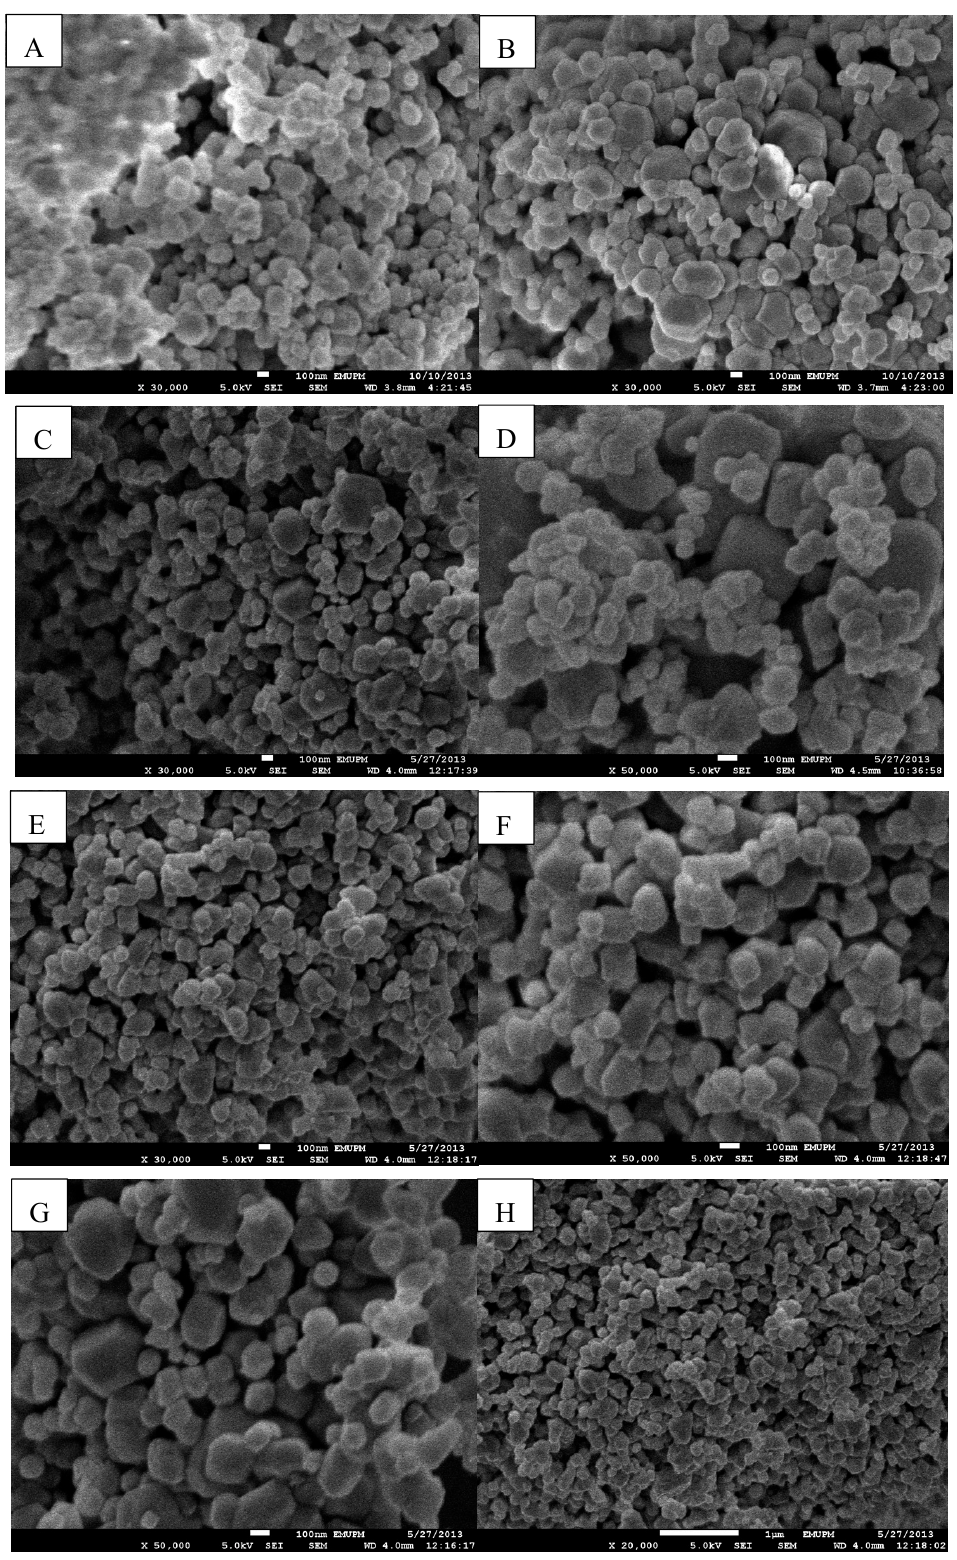
Figure 4. FE-SEM figures of ( A ) Ni/MgO; ( B ) Ni/Mg 0.97 Ce 4+0.03 O; ( C ) Ni/Mg 0.93 Ce 4+0.07 O; ( D ) Ni/Mg 0.85 Ce 4+0.15 O; ( E ) Ni,Pd,Pt/MgO; ( F ) Ni,Pd,Pt/Mg 0.97 Ce 4+0.03 O; ( G ) Ni,Pd,Pt/Mg 0.93 Ce 4+0.07 O; ( H ) Ni,Pd,Pt/Mg 0.85 Ce 4+0.15 O catalysts.